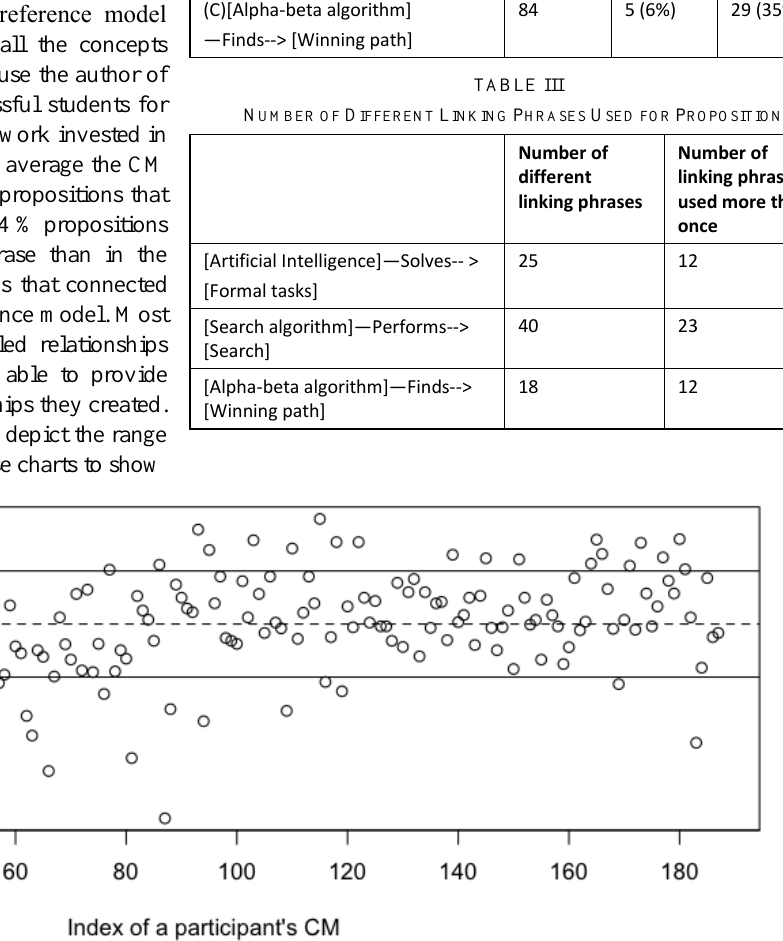
Fig. 4. Ratios of propositions of each class to the total number of propositions in students’